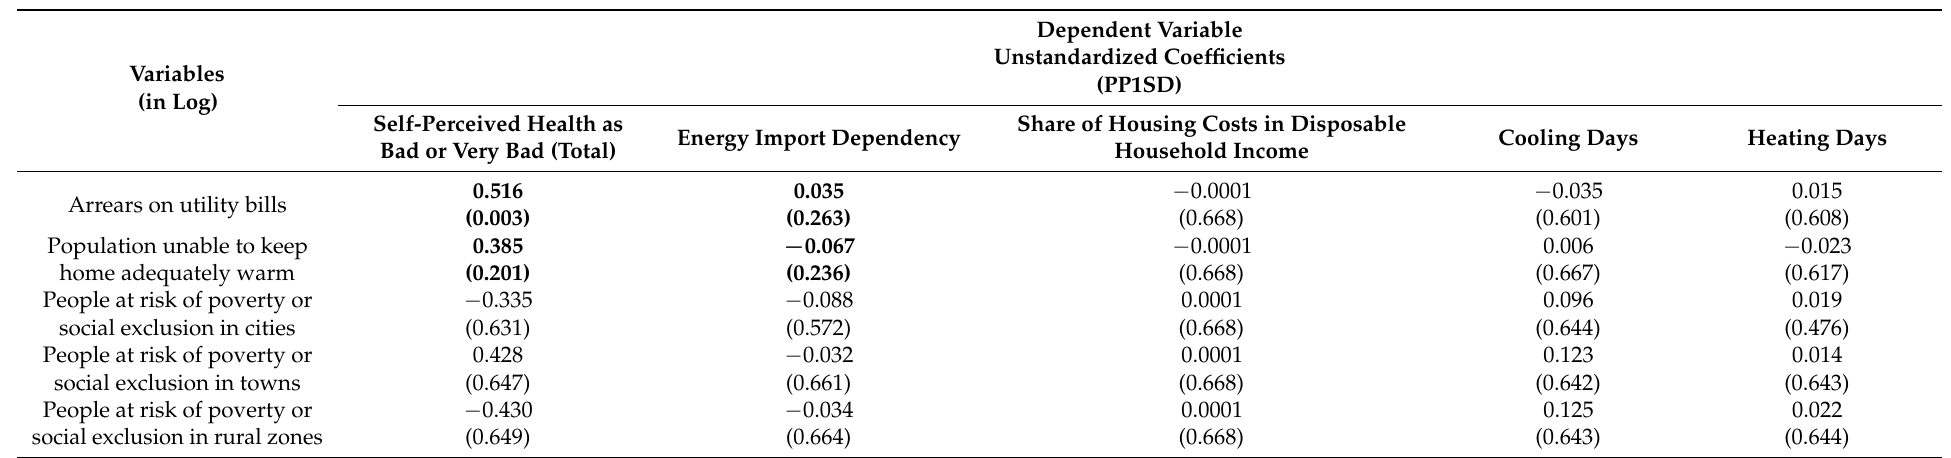
Table 8. The results of generalized ridge regressions for Italy.